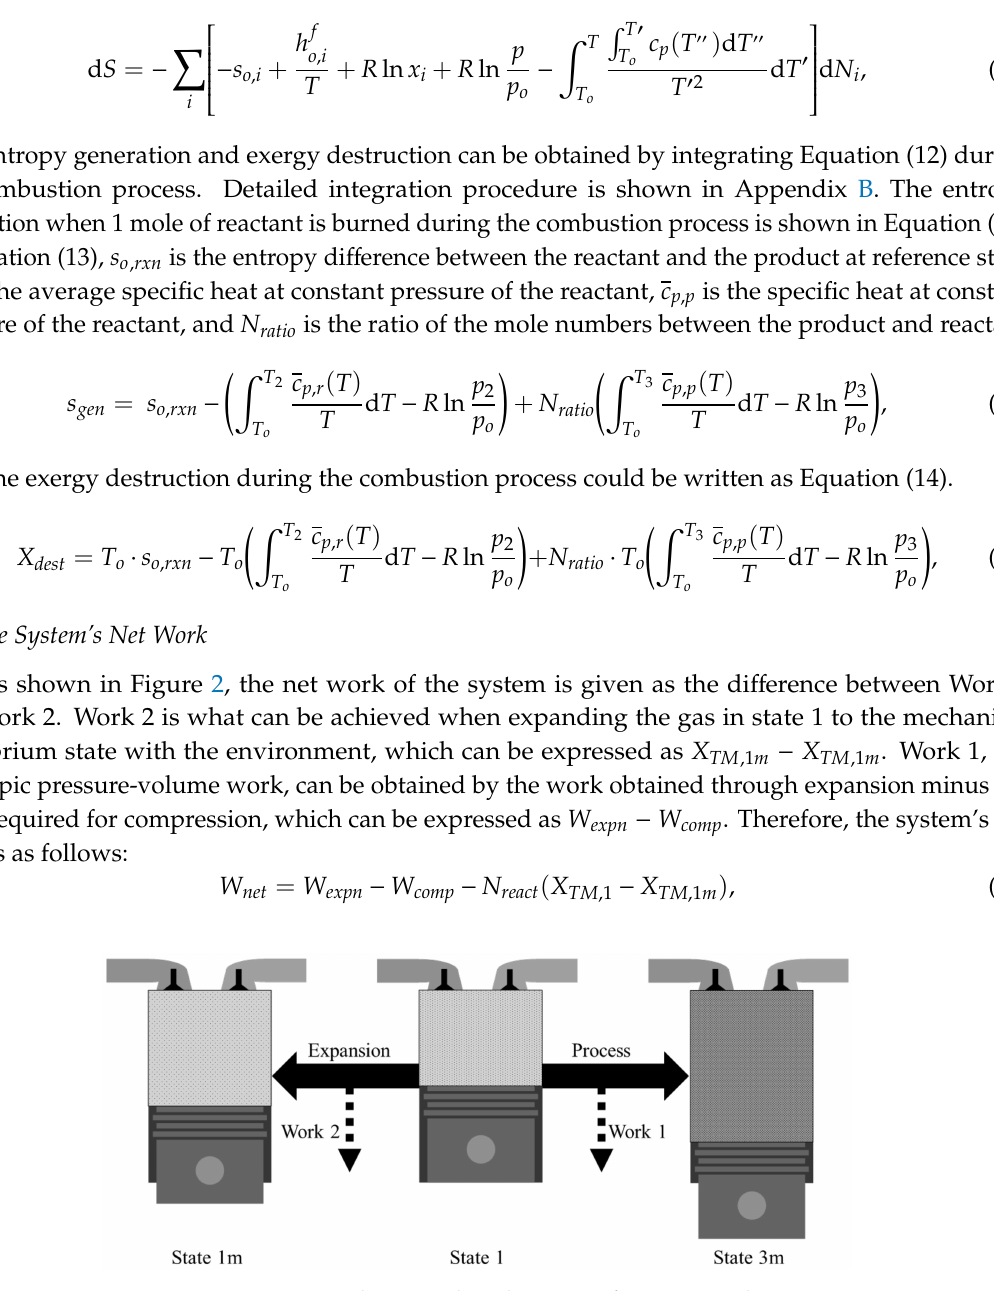
Figure 2. Pressure-volume work in the system from an initial